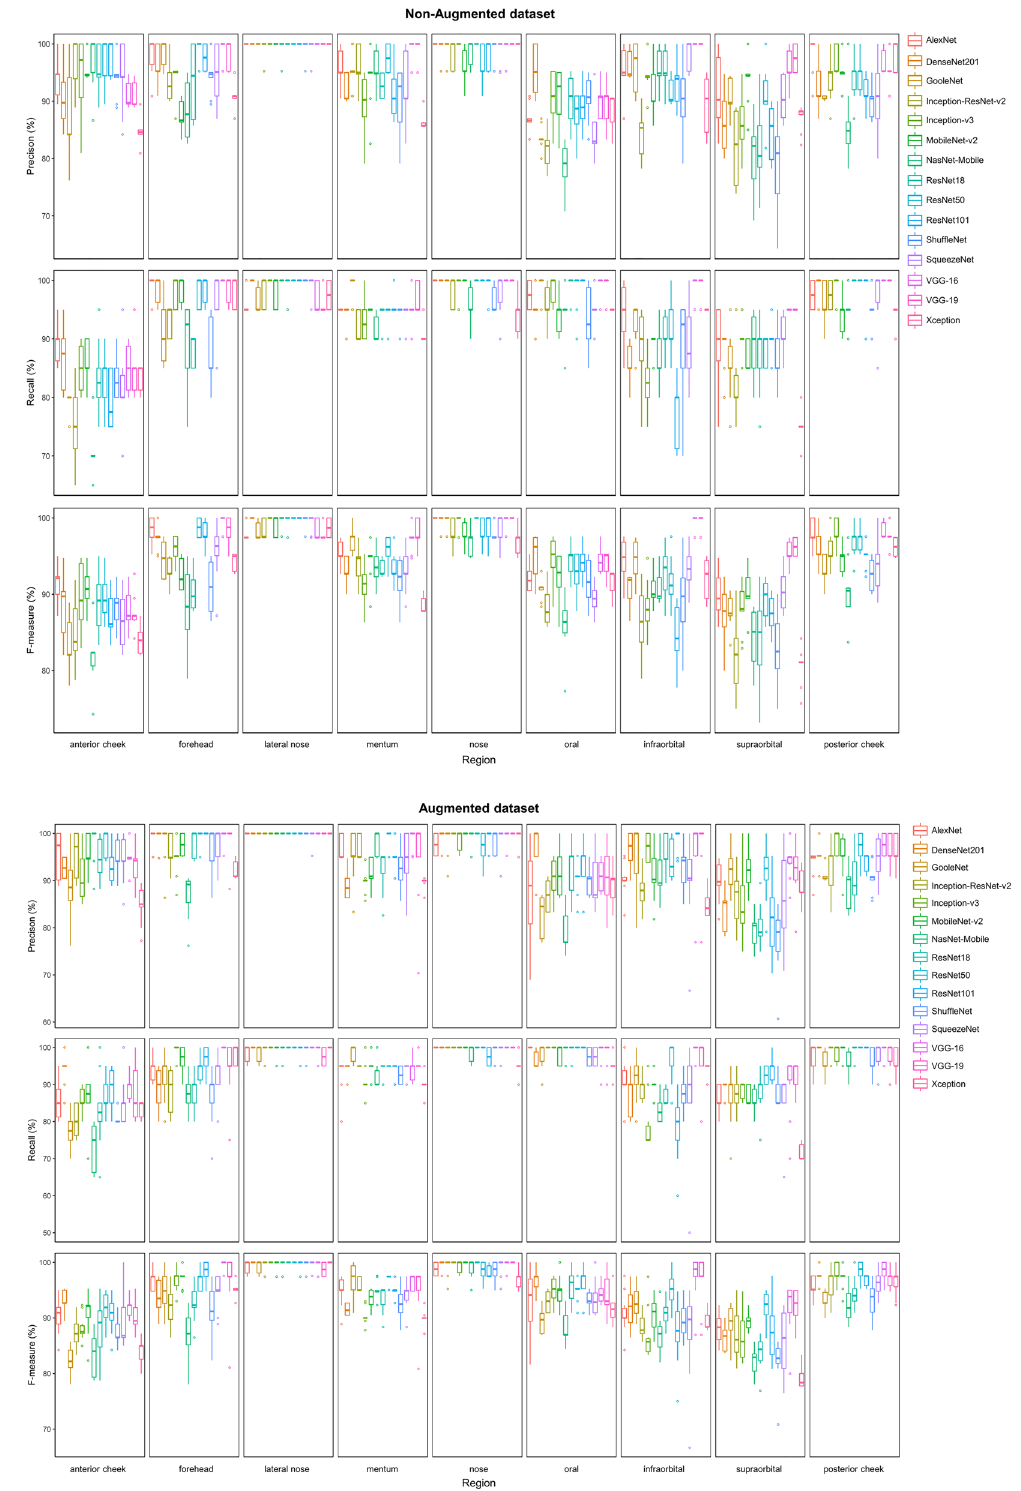
Figure 6. Test results for 10 folds of each deep learning model in each